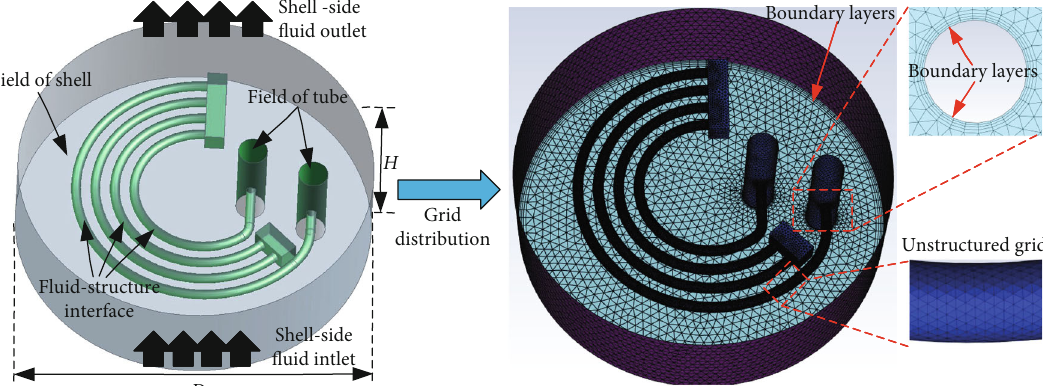
Figure 2: Grid distribution of each fl uid domain.